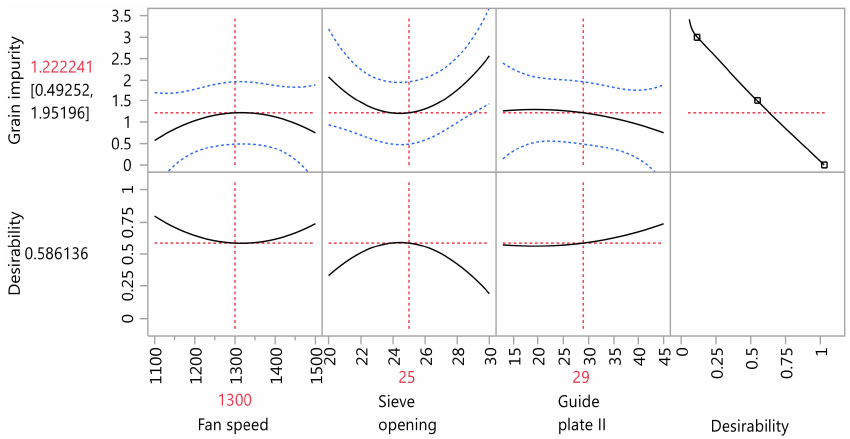
Figure 7. Prediction profiler for grain impurity ratio.